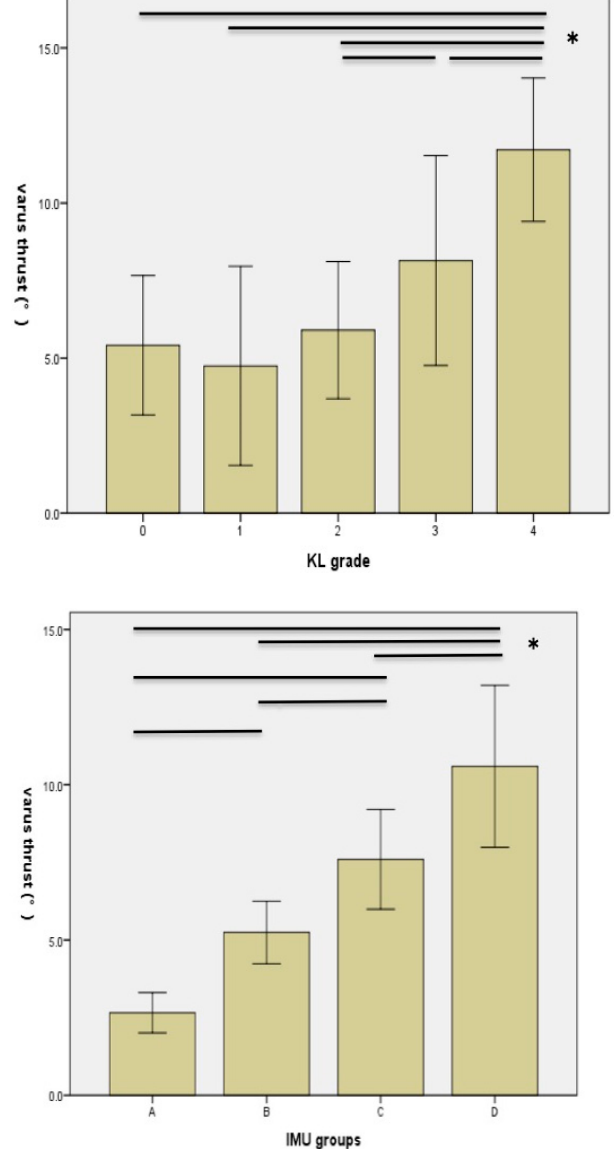
Figure 5. Post-hoc analysis of quantitative varus thrust by KL grade and IMU classification. * p < 0.05